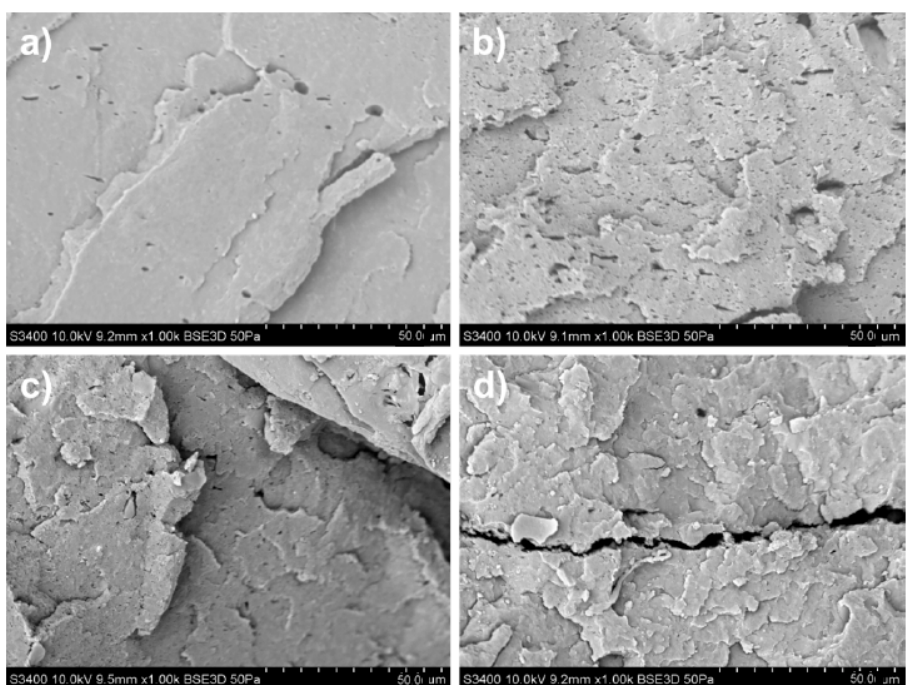
Figure 3. SEM images of fractured surface morphology for ( a ) GD6-FG-PLA-1, ( b ) GD6-FG-PLA-5, ( c ) GD6-FG-PLA-10, ( d ) GD6-FG-PLA-15, Magnification 1000×, PLA-FG—PLA with plasticizer and compatibilizer, GD6—graphite/diamond mixture with 6 wt.% ash content, numbers—wt.% of filler (GD6).